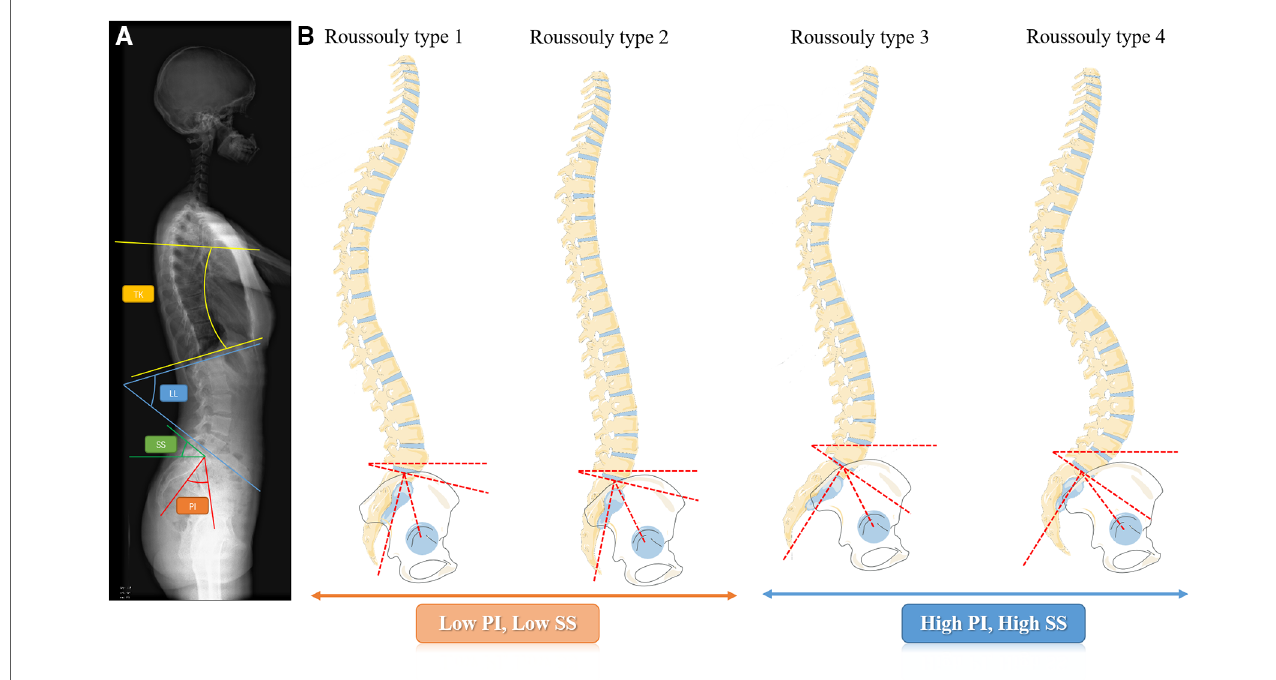
FIGURE 1 ( A ) The spino-pelvic parameters measured in the full-length plain radiography; ( B ) the roussouly classi fi cation: type 1: the sacral slope is less than 35°. The apex of the lumbar lordosis is located in the center of L5 vertebral body, The lower arc of lordosis is minimal, showing an incongruous long thoracolumbar kyphosis and short lumbar lordosis curve. Type 2: The sacral slope is less than 35°. The apex of the lumbar lordosis is located at base of the L4 vertebral body. The lower arc of lordosis is relatively fl at. Type 3: The sacral slope is between 35° and 45°. The apex of lumbar lordosis is located at the center of the L4 vertebral body, showing a coordinated curve of almost equal length of thoracic kyphosis and lumbar lordosis. Type 4: the sacral slope is greater than 45°, which is associated with a high pelvic incidence. The apex of the lumbar lordosis is located at the base of the L3 vertebral body or higher, showing a coordinated longer lumbar lordosis and a shorter, larger thoracic kyphosis curve.